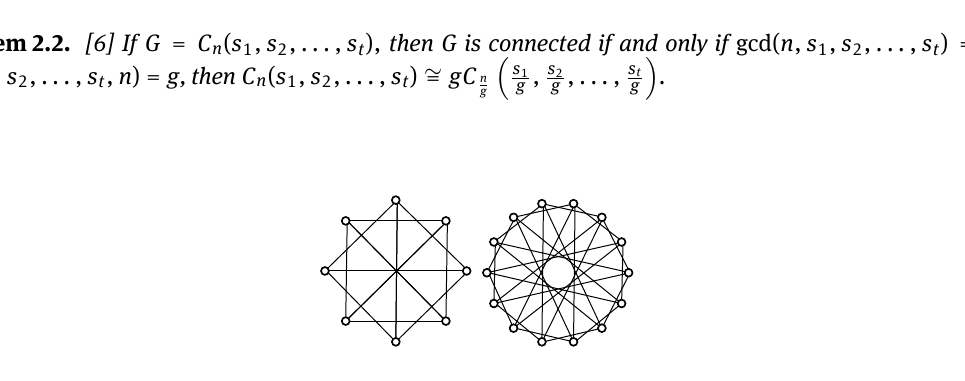
Using the function f : Z n → Z n , defined by f ( x ) = kx , Muzychuk [19] proved the following graph isomor- phism between circulant